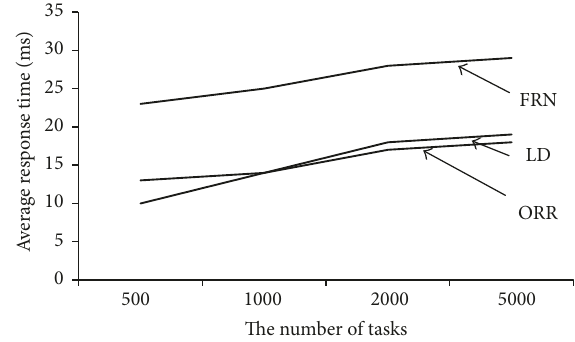
Figure 6: The comparison of average response time.